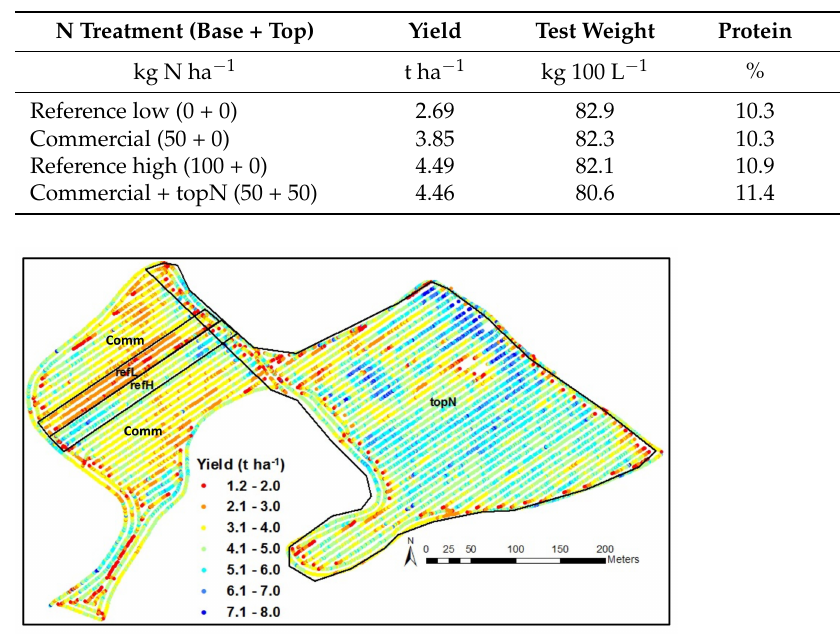
Figure 10. Wheat grain yield (raw data, t ha − 1 ) map of Beit Guvrin, field 109, 2020 season. N management is described in Table 4.